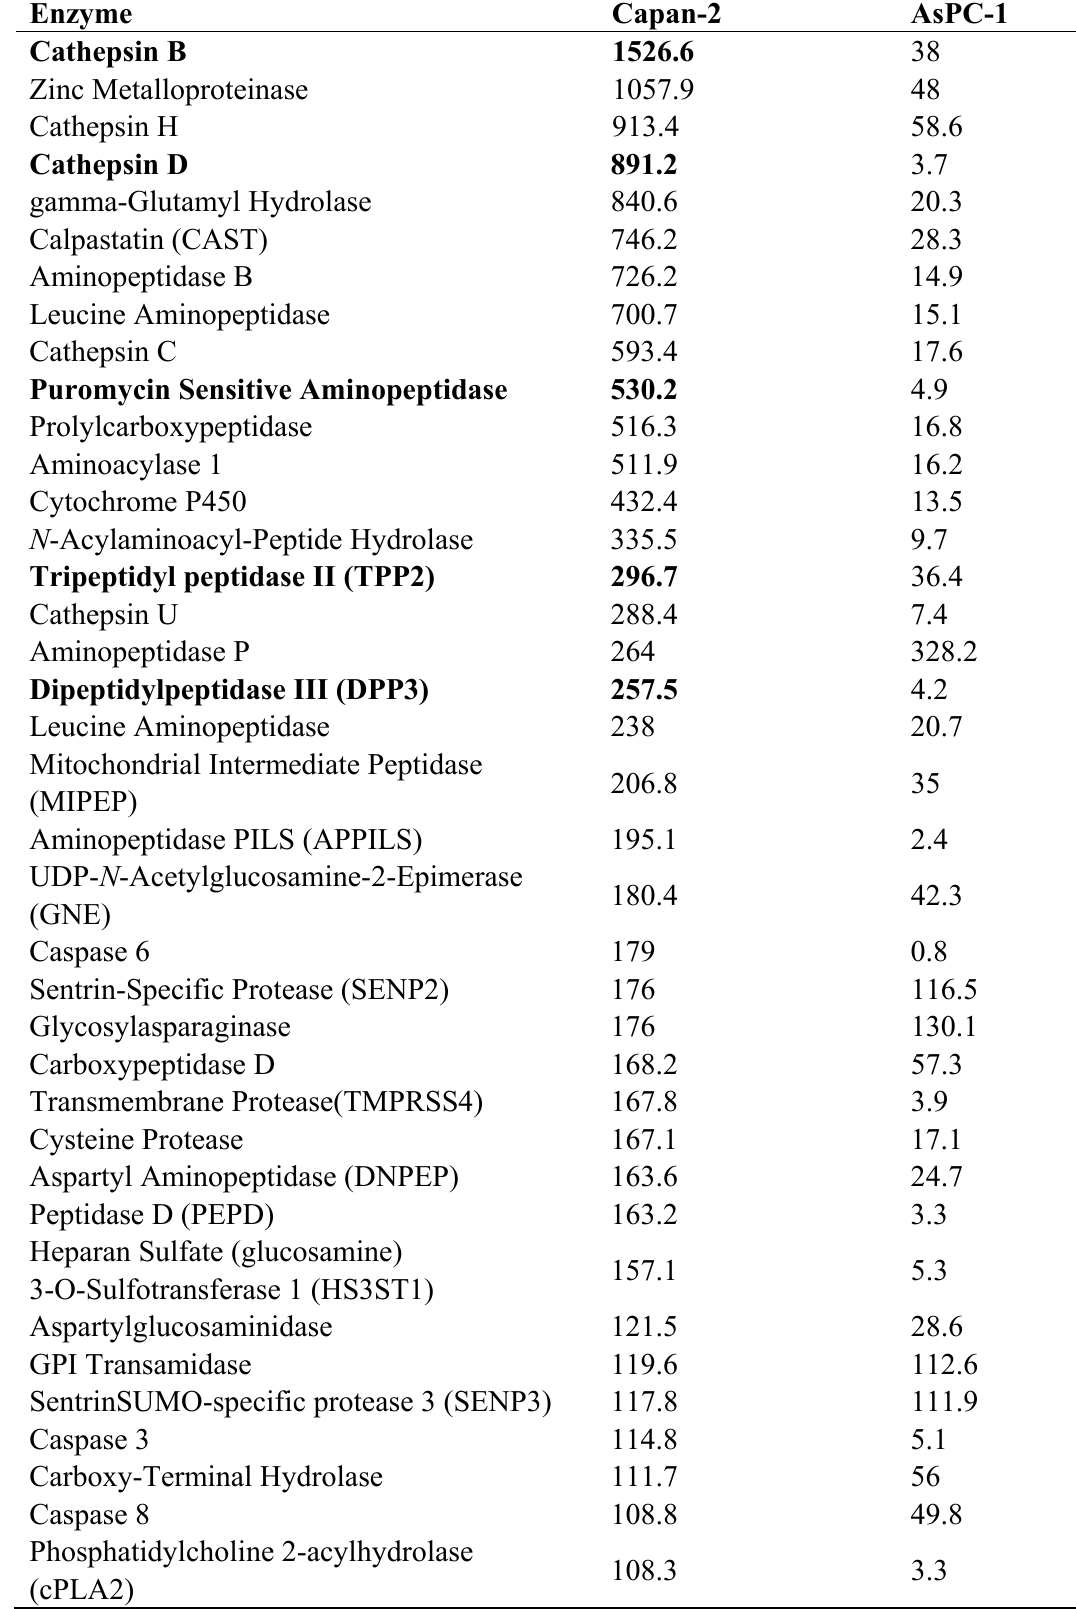
Table 1. Expression levels of top 50 enzyme genes in plasma membrane and cytosol with cathepsins in pancreatic cancer cell line, capan-2 and AsPC-1, with Affymetrix GeneChip Human Genome U133 Plus